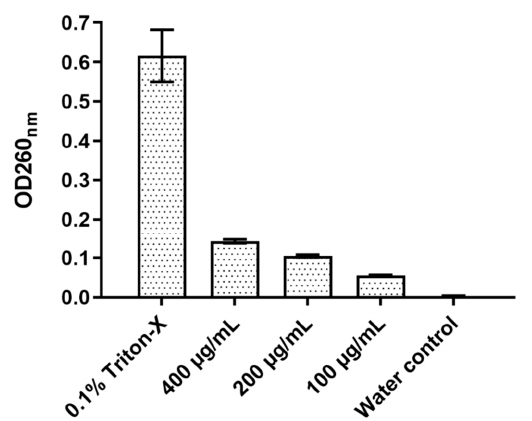
Figure 6. The total nucleotide leakage detected from Z. bailii 6 h after inoculation and incubations with the peptide at different concentrations.